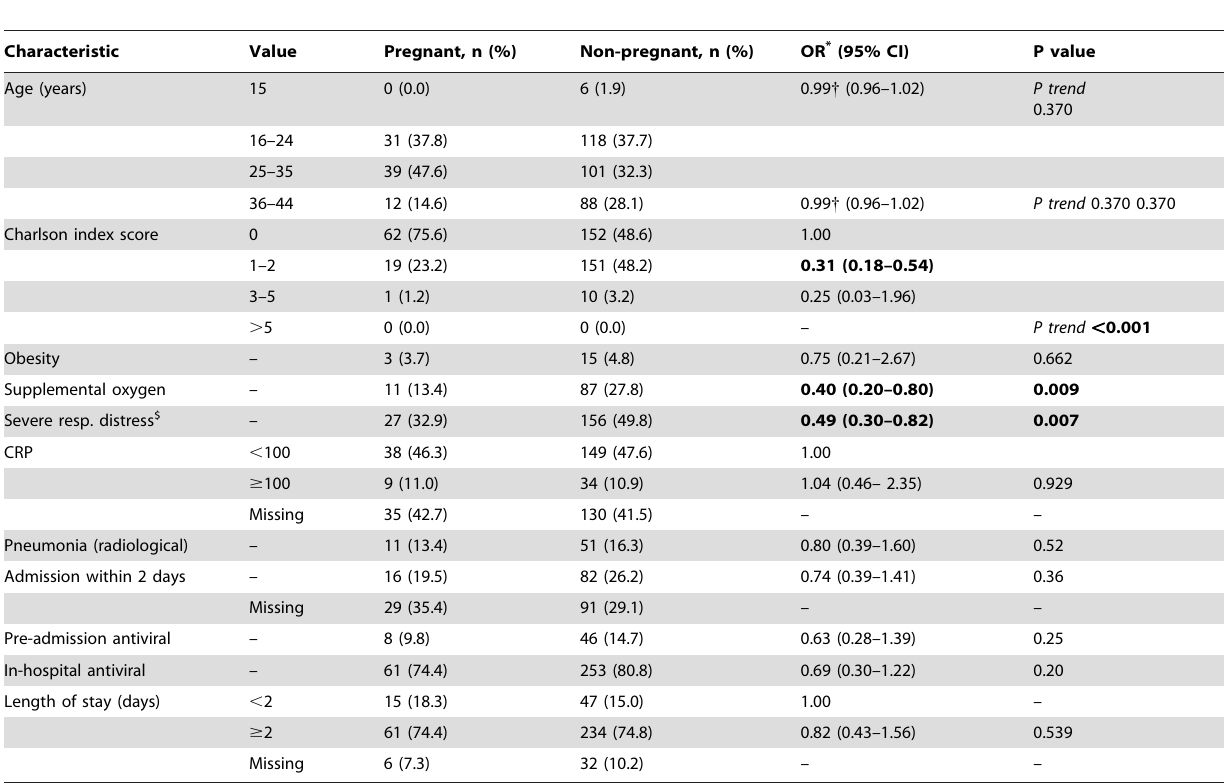
Table 1. Comparison of patient characteristics for pregnant and non-pregnant women of child-bearing age from the FLU-CIN